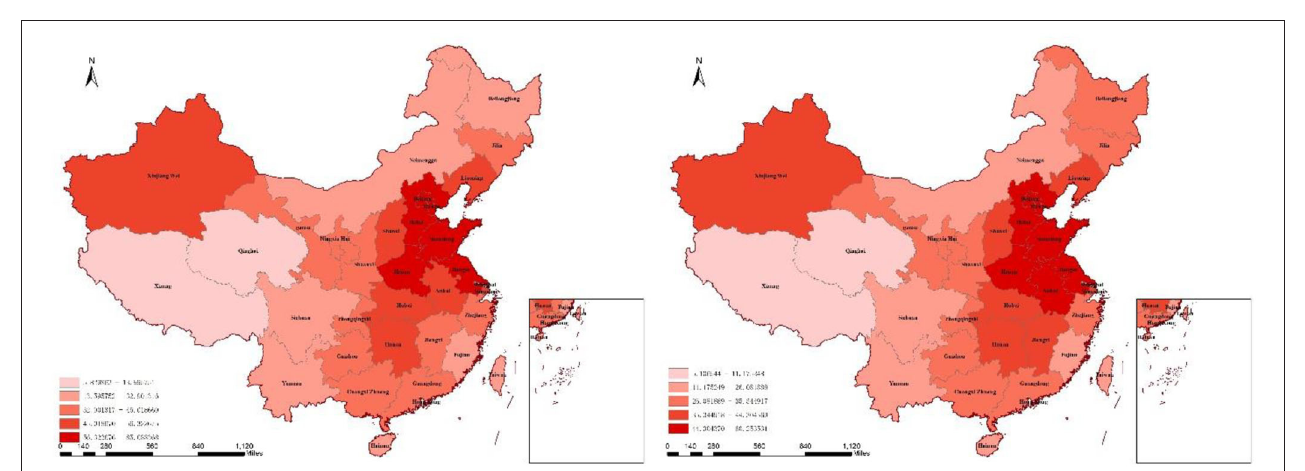
FIGURE 2 | Foreign direct investment (FDI) in 2014 and 2017.